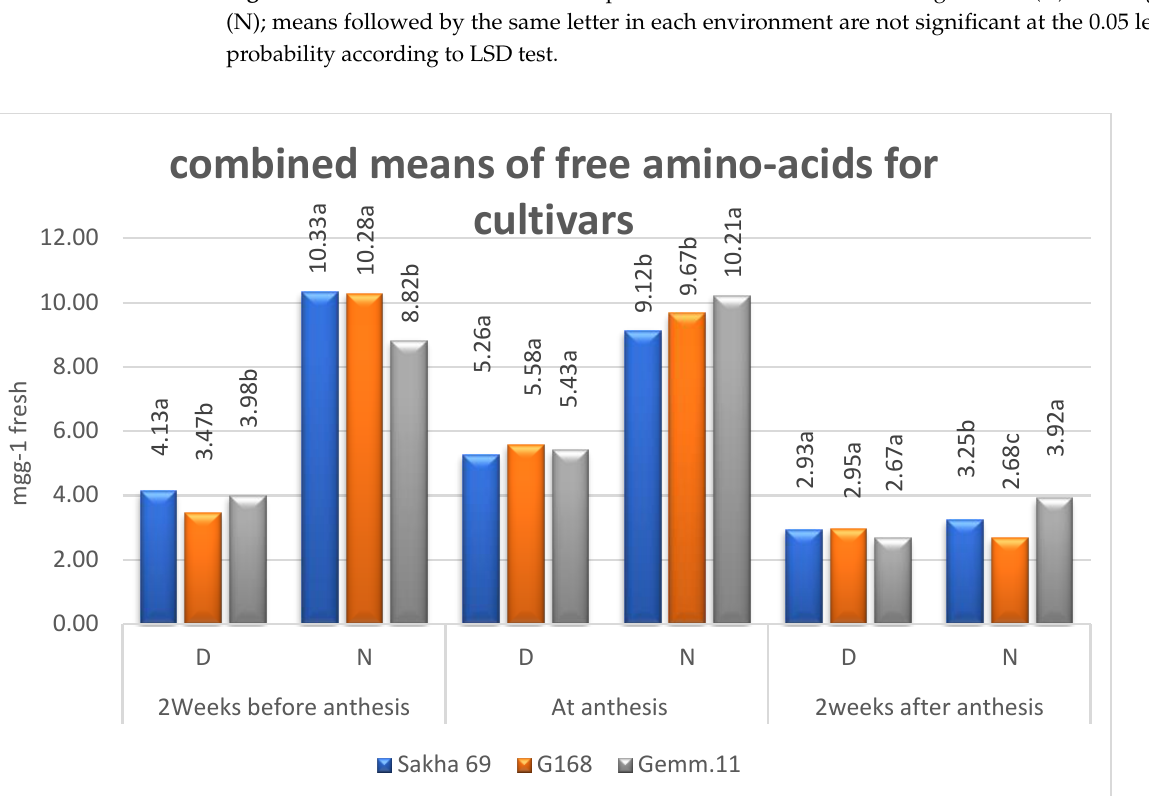
Figure 6. Combined means of free amino acids for cultivars under drought stress (D) and irrigation (N); means followed by the same letter in each environment are not significant at the 0.05 level of probability according to LSD test.